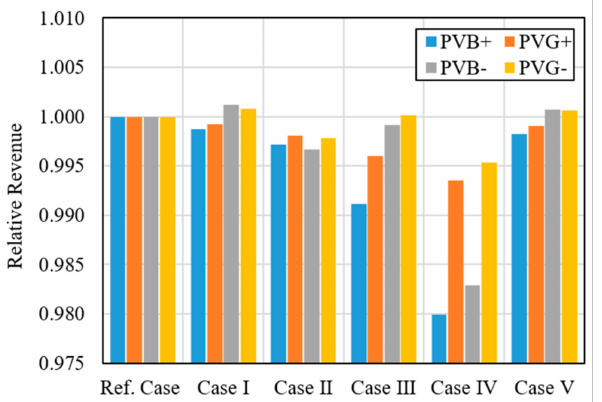
Figure 5. Average revenue of each PV in each group according to imbalance pricing